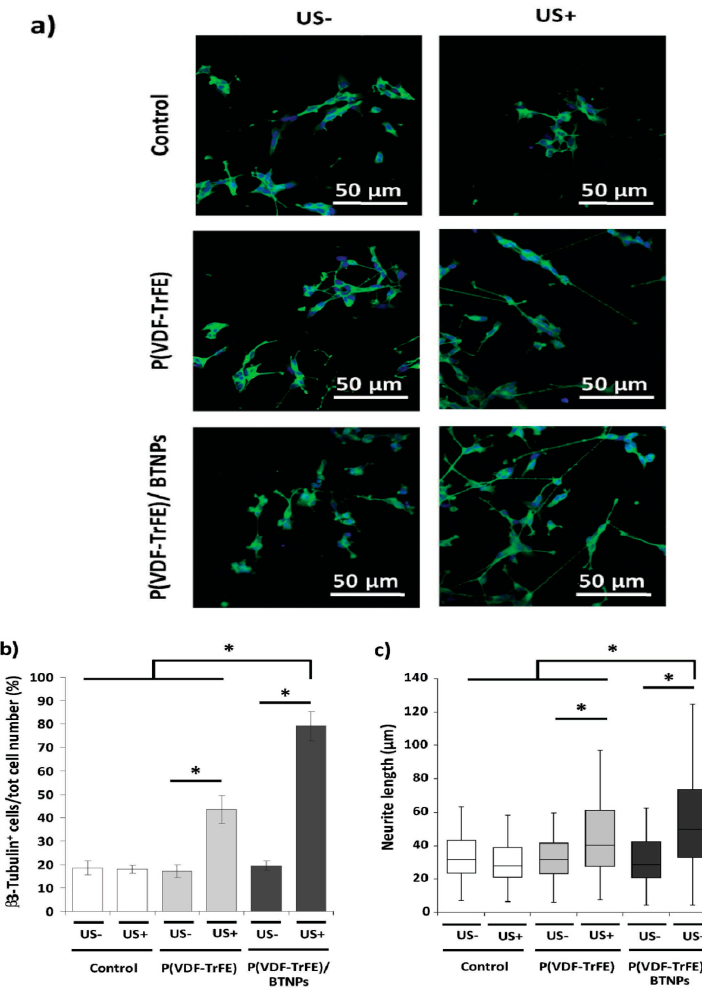
Figure 28. ( a ) Confocal fluorescence microscopic images of SH-SY5Y cells on solvent-cast P(VDF-TrFE) and P(VDF-TrFE)/BTNP films, as well as Ibidi (control) at the end of differentiation period of 6 days. SH-SY5Y cells were treated with or without ultrasound stimulation (US+ or US − ). β 3-tubulin was stained in green, nuclei in blue. ( b ) Percentages of β 3-tubulin positive cells. ( c ) Neurite lengths are expressed as median values ± confidence interval at 95%. * p < 0.05. Reproduced with permission from [182], published by Wiley-VCH, 2016.